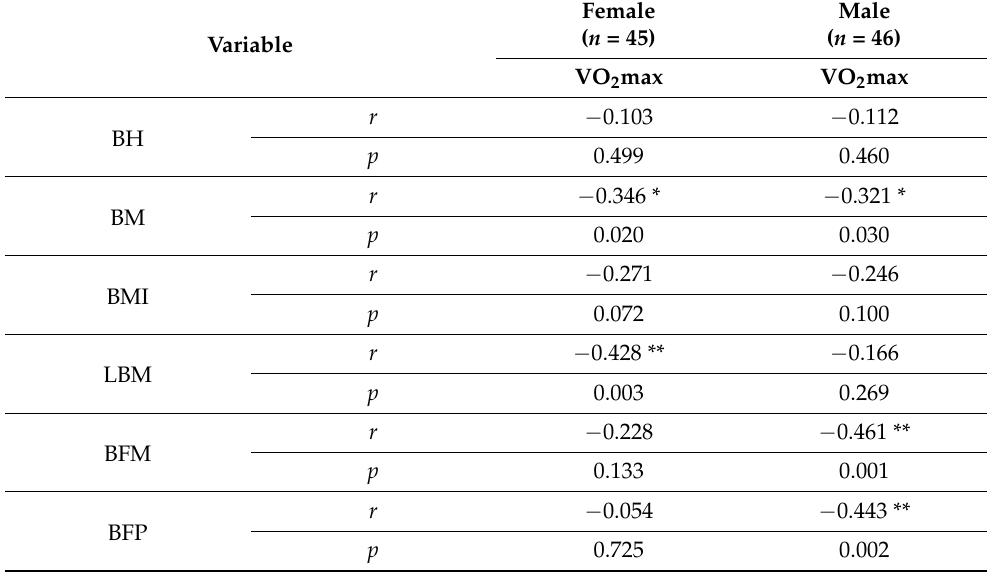
Table 3. Results of Pearson’s r correlation test examining relationships between maximal oxygen uptake and selected somatic